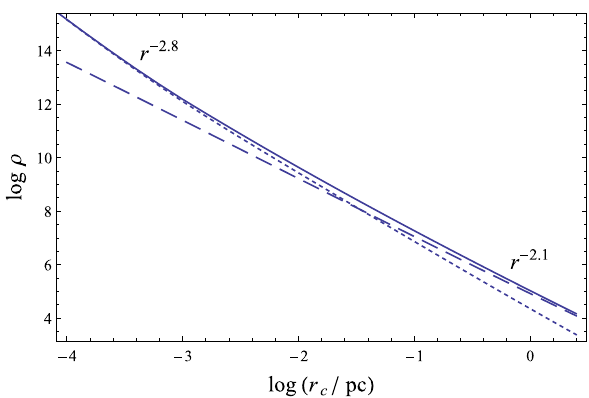
Fig. 5 Density profile (22) for dark matter (dashed line), BHs (dotted line), and for the total density (solid line). The asymptotic power-law lines are shown. The density and radius from the center are in M (cid:2) pc − 3 and pc unints,